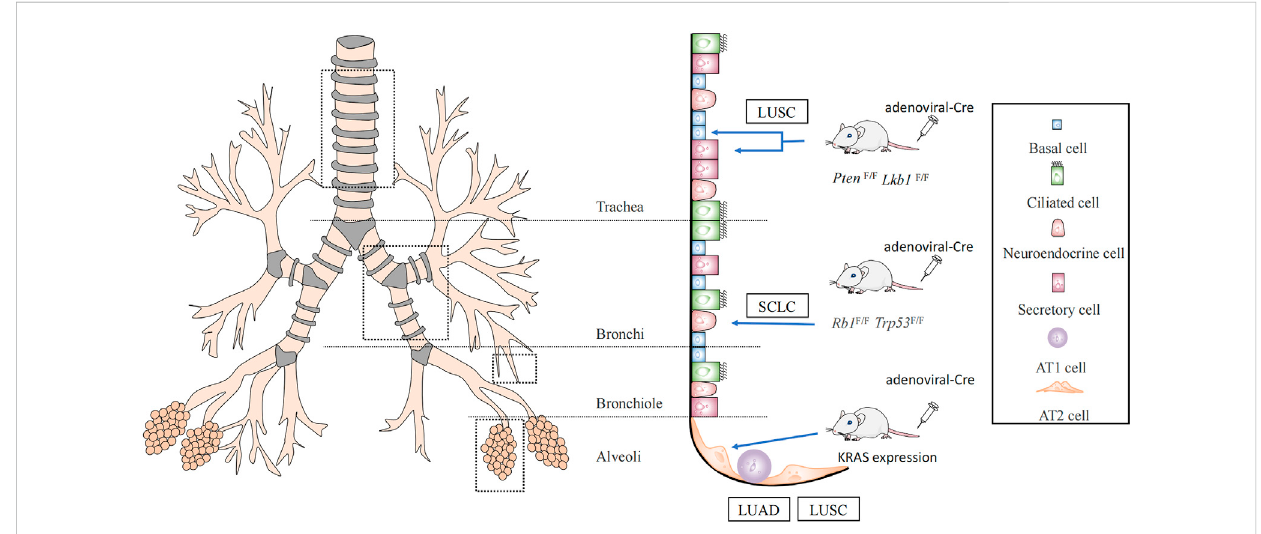
FIGURE 1 Lung cancer cells of origin. It was demonstrated by Cre mice that lung squamous cancer (LUSC) originates from basal cells with secretory cells, AT2 cells, while AT2 cells may also evolve into lung adenocarcinoma (LUAD). And small-cell lung cancer (SCLC) originates from neuroendocrine